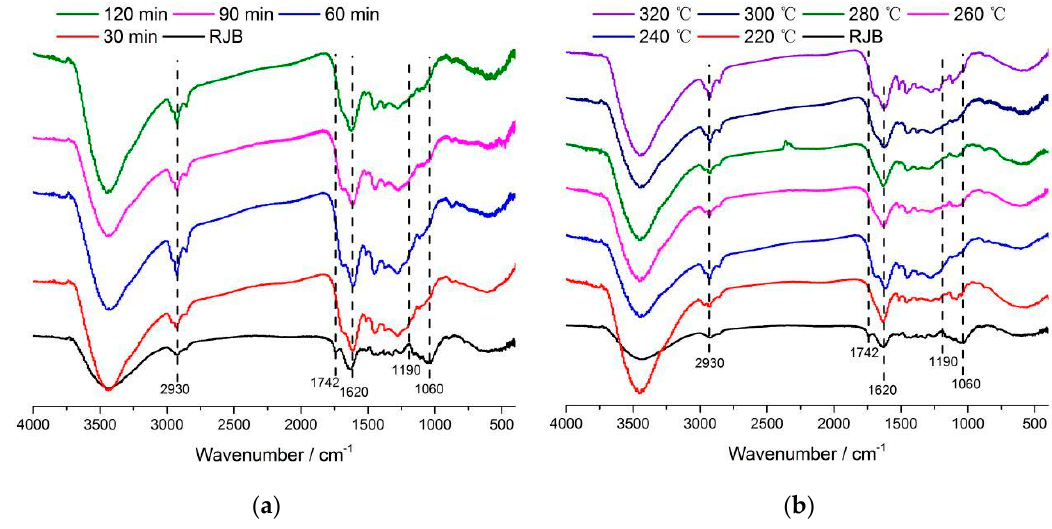
Figure 4. FT-IR spectra of RJB and its derived hydrochars. ( a ) Residence time; ( b ) reaction temperature.